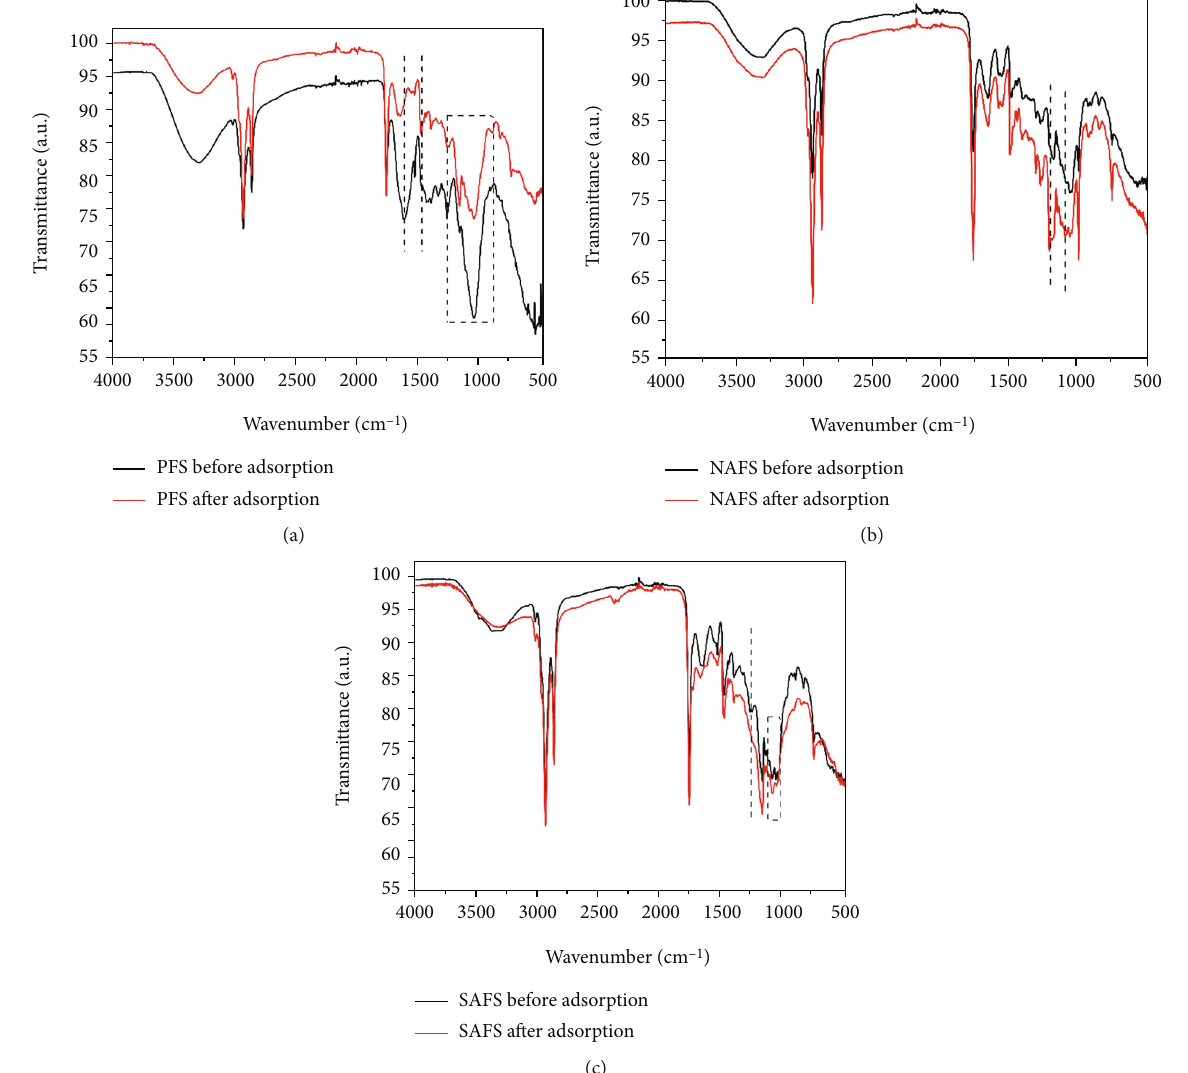
Figure 10: FTIR spectra (a) PFS, (b) NAFS, and (c) SAFS before and after